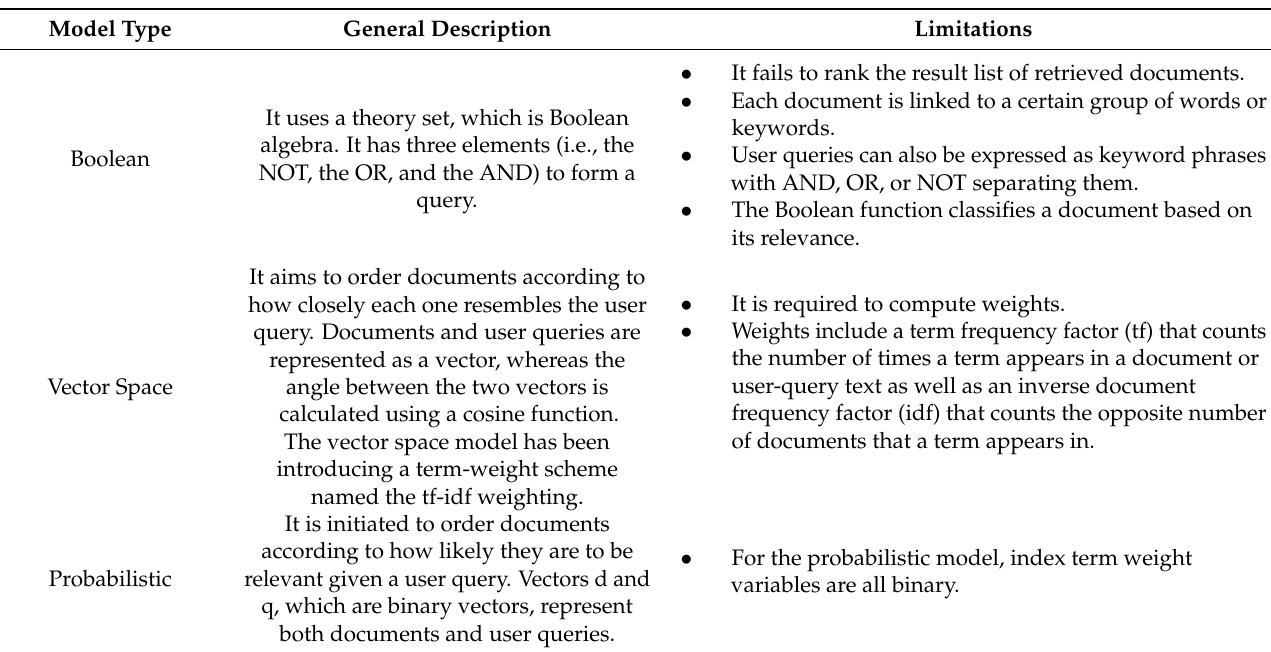
Table 1. General description and limitations of IRS models.